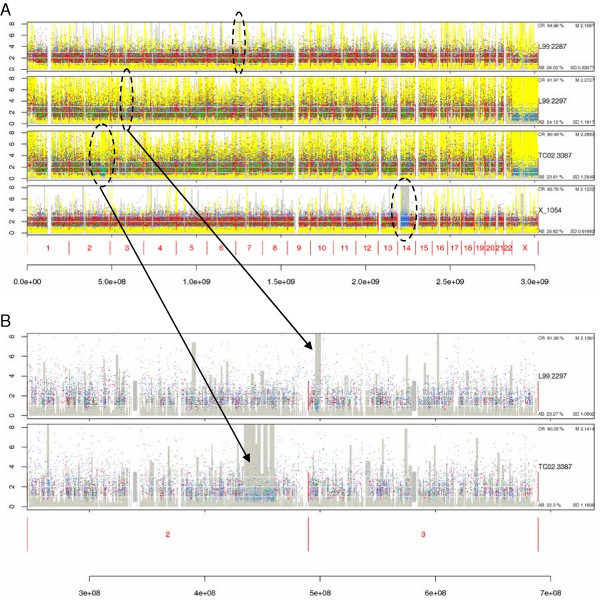
Use of SNPscanPlot to visualize microdeletions and UPD. A. SNPscanPlot visualization of cases involving microdeletions on chromosome 7 (top row; case L99-2287), 3 (second row; case L99-2297) and 2 (third row), and uniparental isodisomy of chromosome 14 (fourth row; case X_1054). The x-axis spans chromosomes 1–22 and X. B. Detailed view of microdeletions on chromosome 3 (top row) and 2 (bottom row). The x-axis spans chromosomes 2 and 3.